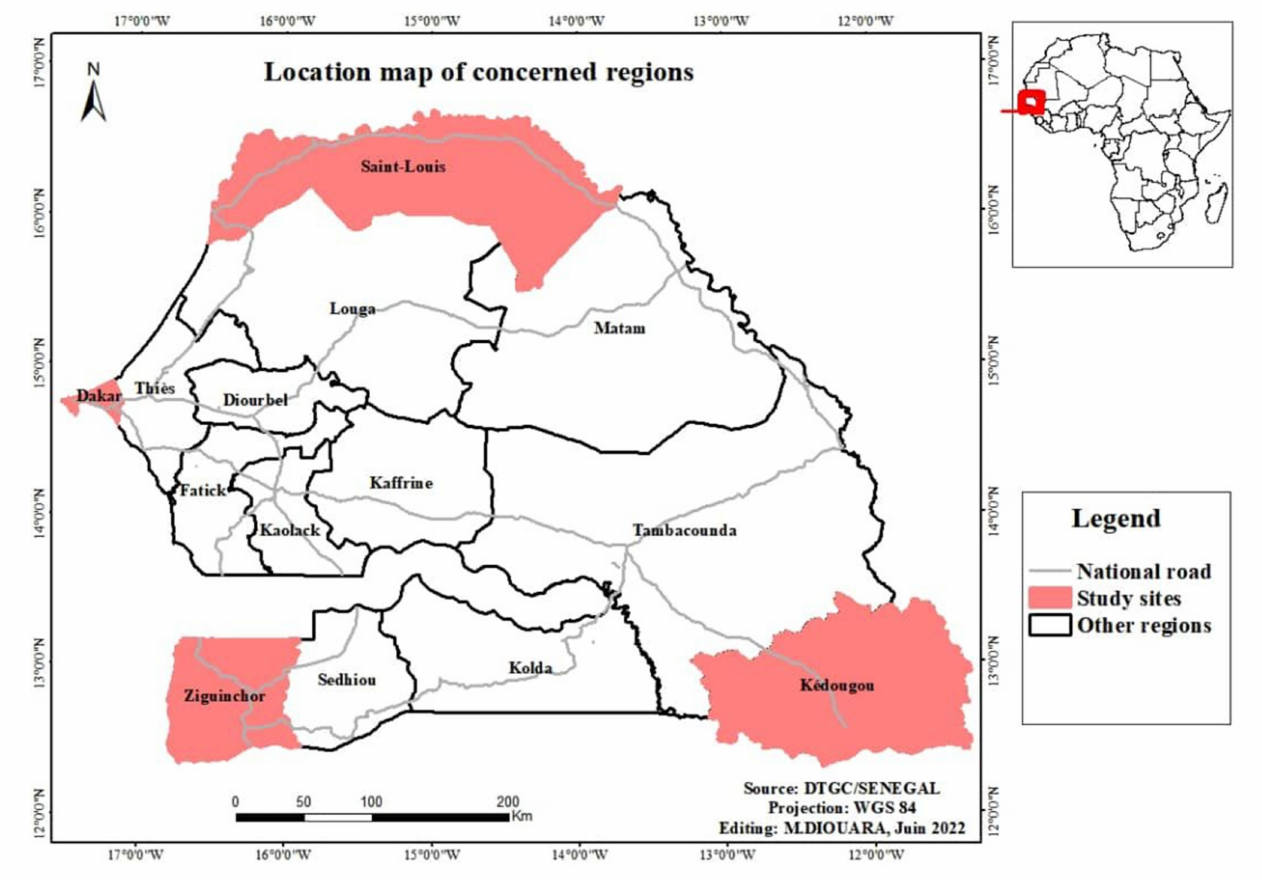
Figure 1. Map of Senegal, with indication of the geographical sites of the